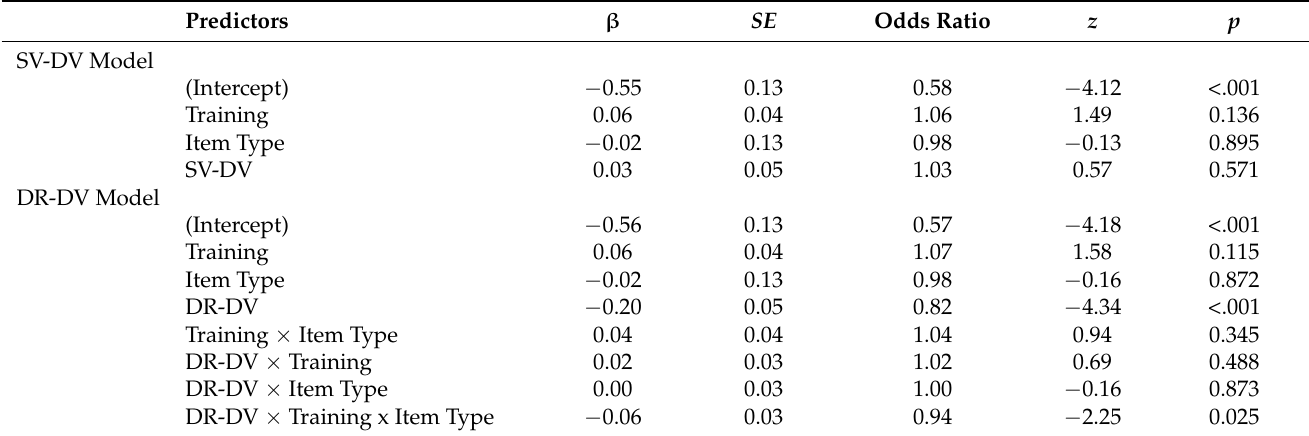
Table 10. Predicting figural analogy accuracy with same version–different version and different rule–different version measures, training, and item